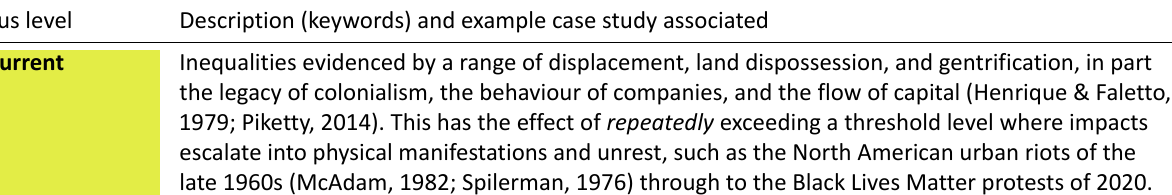
Table 2. (Cont.) Definitions of negative interventions to segregation and inequalities. Litmus level